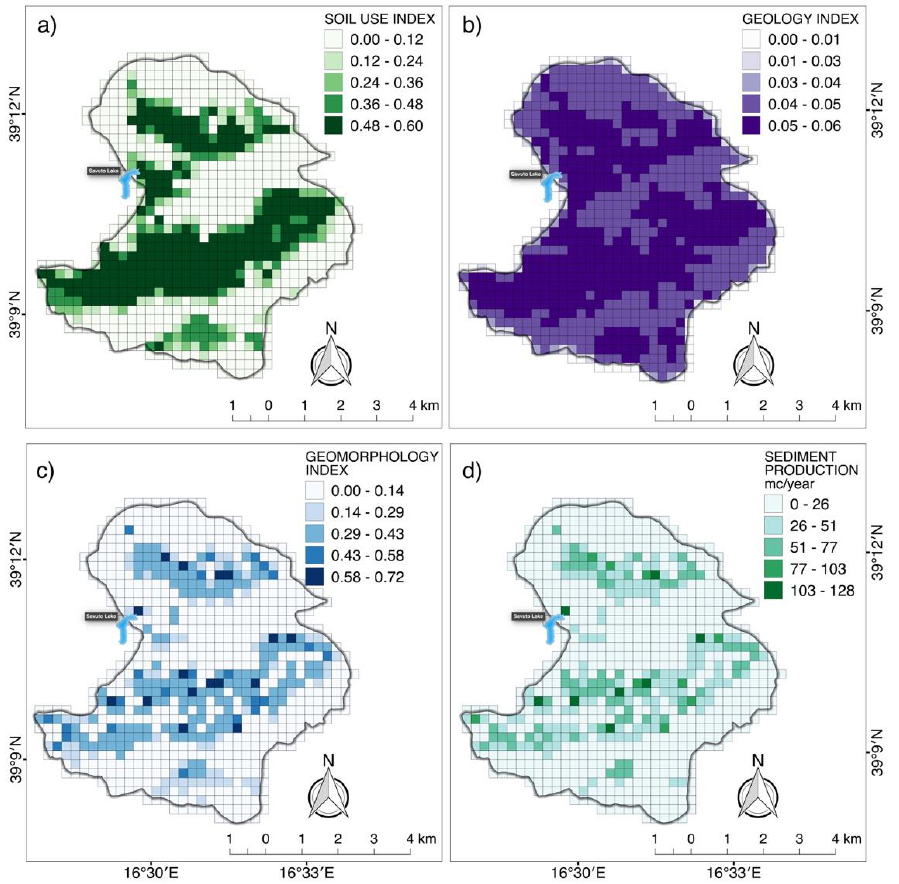
Figure 8. Distribution maps of soil use index X ( a ), geology index Y ( b ), geomorphology index φ ( c ) and sediment production W y ( d ). Table 2. Coe ffi cient values for soil resistance, soil use and geomorphology used for the estimation of sediment production in the Savuto Lake